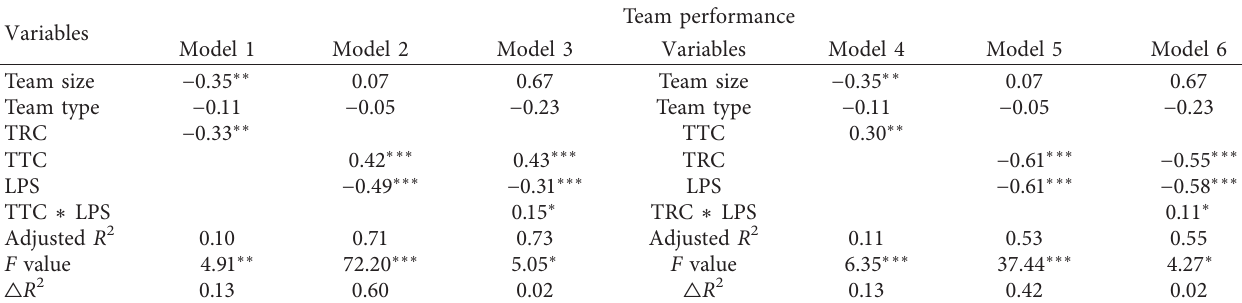
Table 3: Effect of leader political skills on relationship between team conflict and team performance.